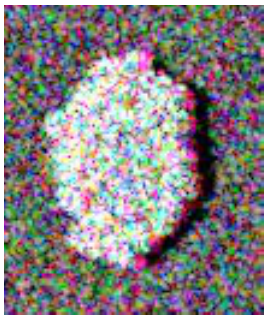
Figure 2. Pauli decomposition image of the simulated data